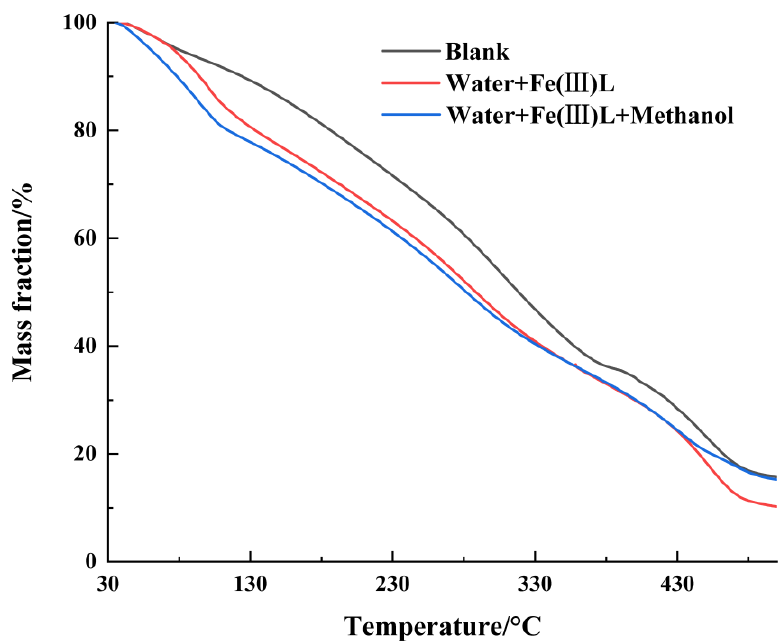
Figure 7. The TG curves of the crude oil before and after aquathermolysis.